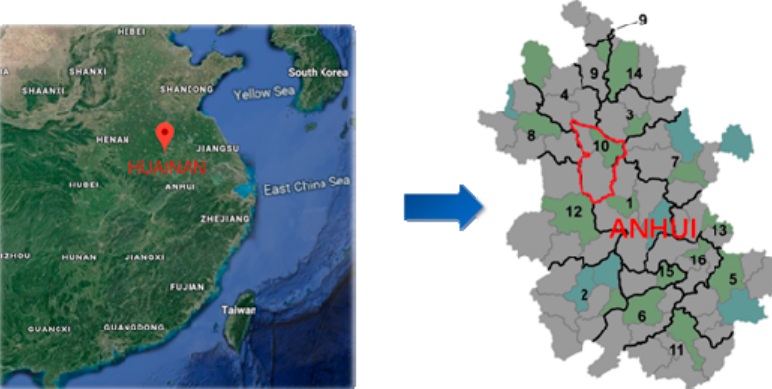
Figure 1. The geographical location of Huainan. The red area represents Huainan in Anhui Province.